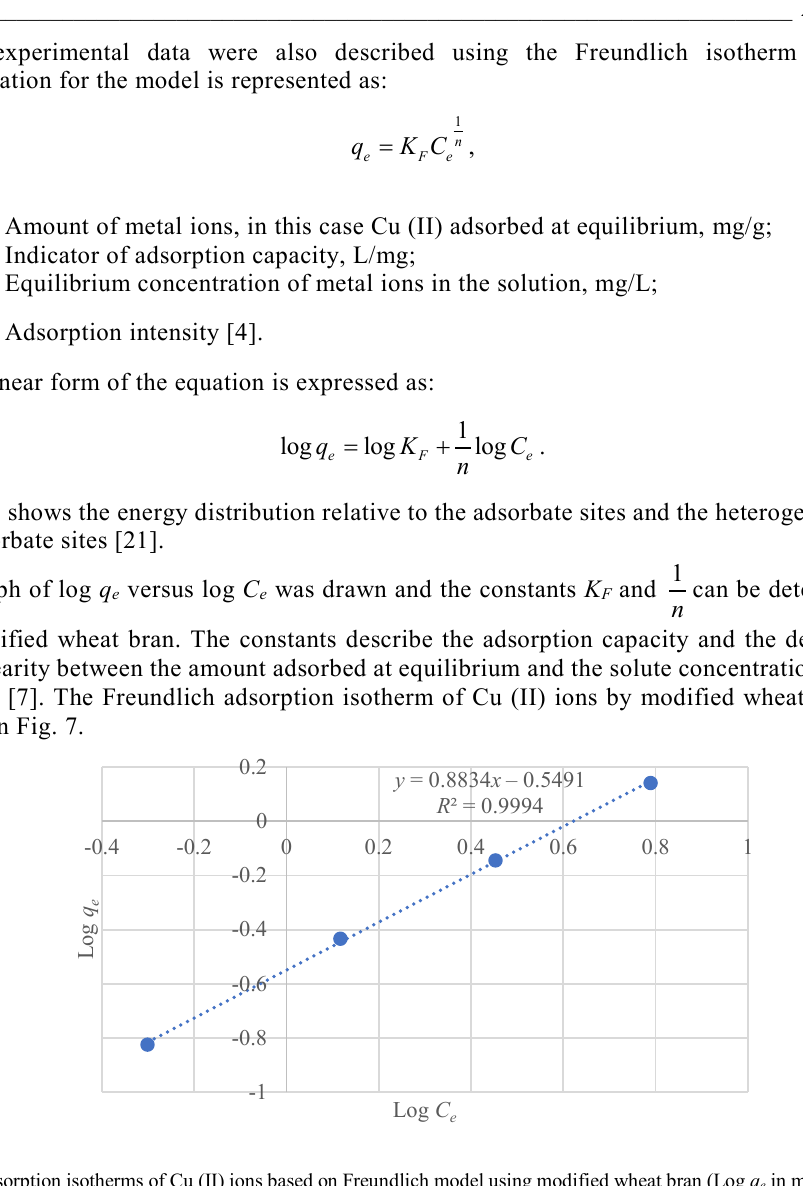
Fig. 7. Adsorption isotherms of Cu (II) ions based on Freundlich model using modified wheat bran (Log q e in mg/g on the y-axis represents the logarithm of the amount of Cu (II) ions adsorbed at equilibrium and Log C e in mg/L on the x-axis represents the logarithm of the equilibrium concentration of metal ions in the